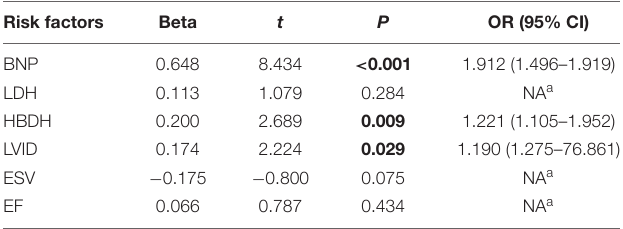
TABLE 4 | Multivariate correlation of clinically relevant indicators between matched AL and control group patients (related variables). Risk factors